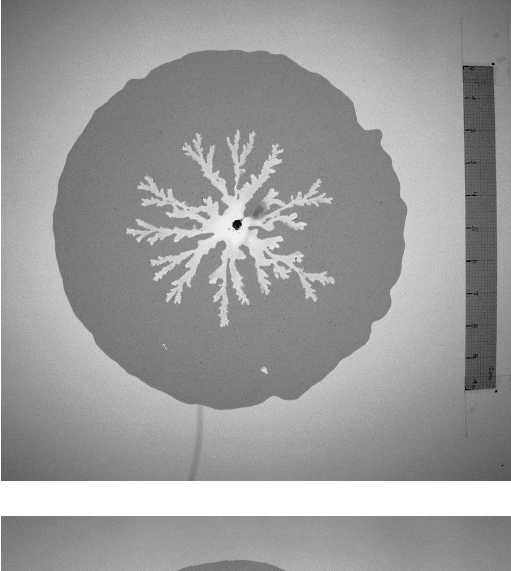
Figure 3 (left): Experimental set-up (Hele-Shaw cell). Figure 5a (right above): Distilled water as injection fluid. Figure 5b (right middle): Praestol 630BC solution as injection fluid. Figure 5c (right below): Gum Xanthan solution as injection fluid.